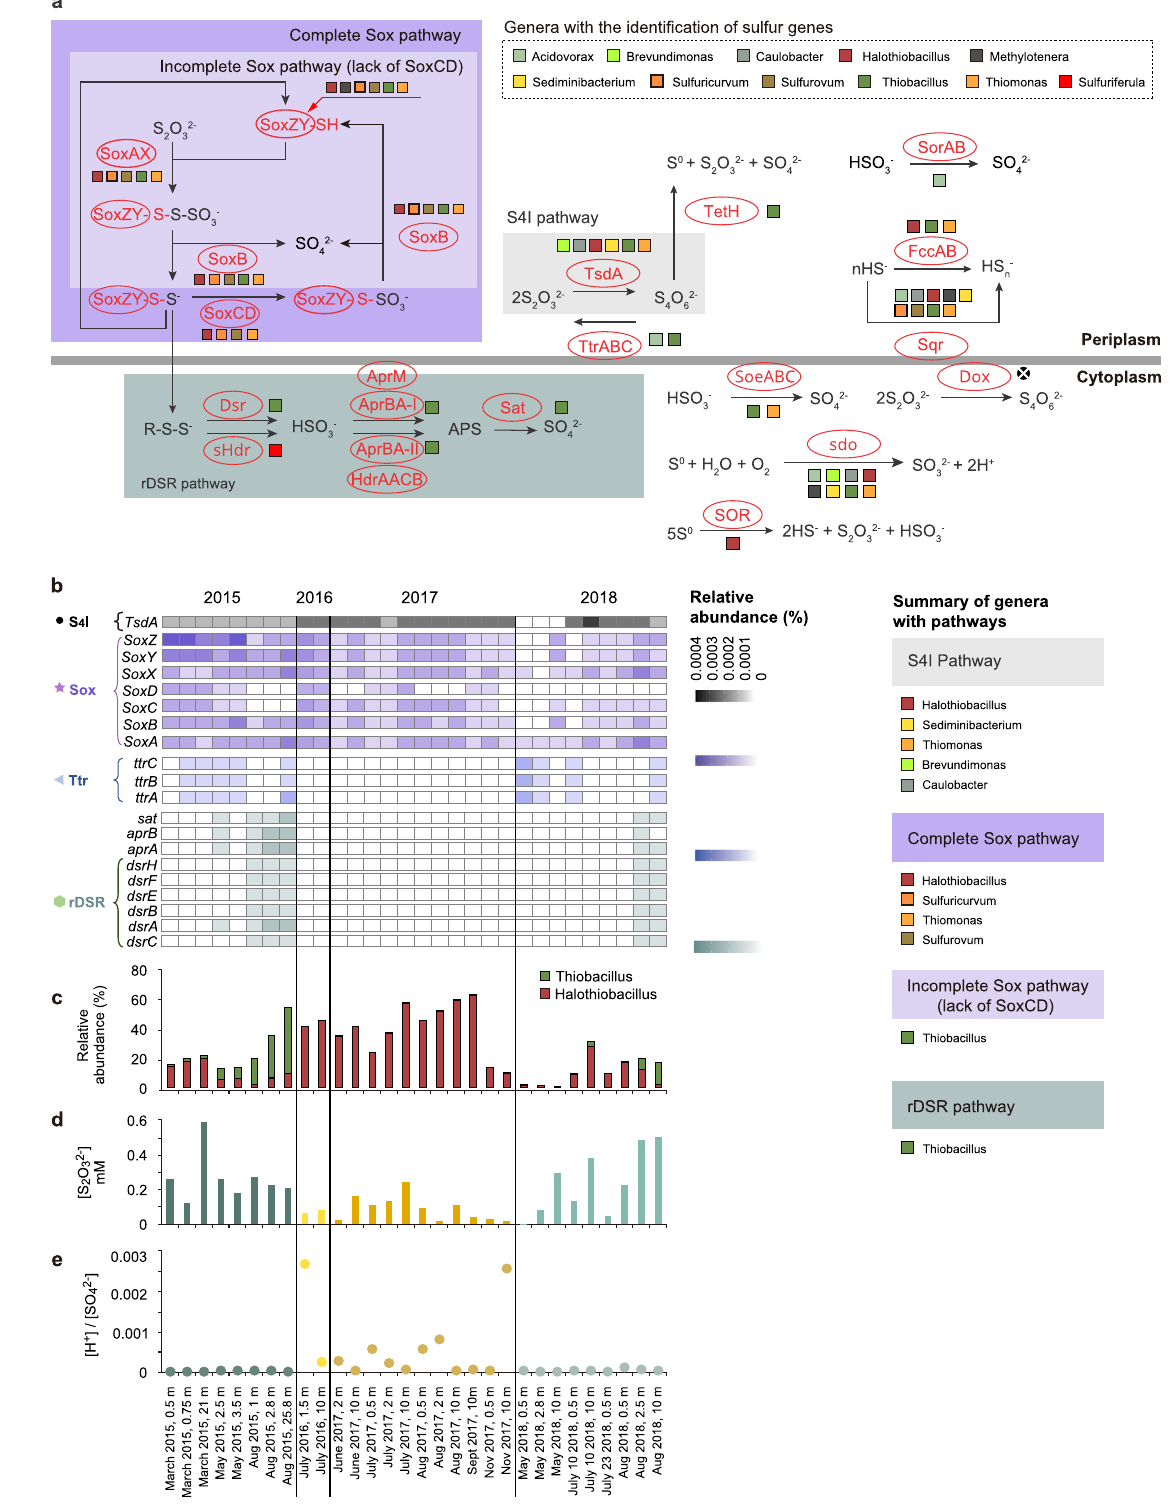
Fig. 2 | Metabolic capacity for sulfur oxidative strategies over time in the tailings impoundment/pit lake, signi fi cant sulfur oxidizers and acidity and thiosulfate outcomes. a Schematic of potential sulfur oxidation pathways based on identi fi ed genes encoding sulfur metabolic enzymes. A black circle with “ X ” indicates the gene was not detected in the genomes of the listed genera. This pathway representation was adapted from Watanabe et al. 28 . b Community level